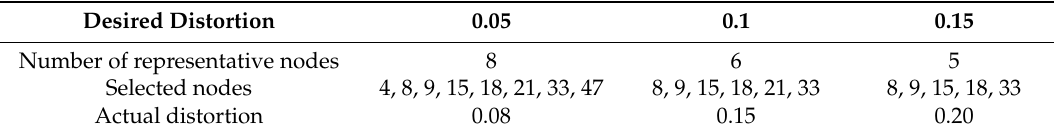
Table 8. Selection of representative nodes and the actual distortion based on the theoretical calculation (dataset 1 with N = 11 nodes).